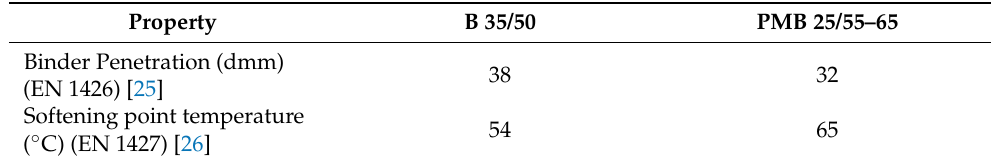
Table 4. Properties of the binders evaluated in the study.